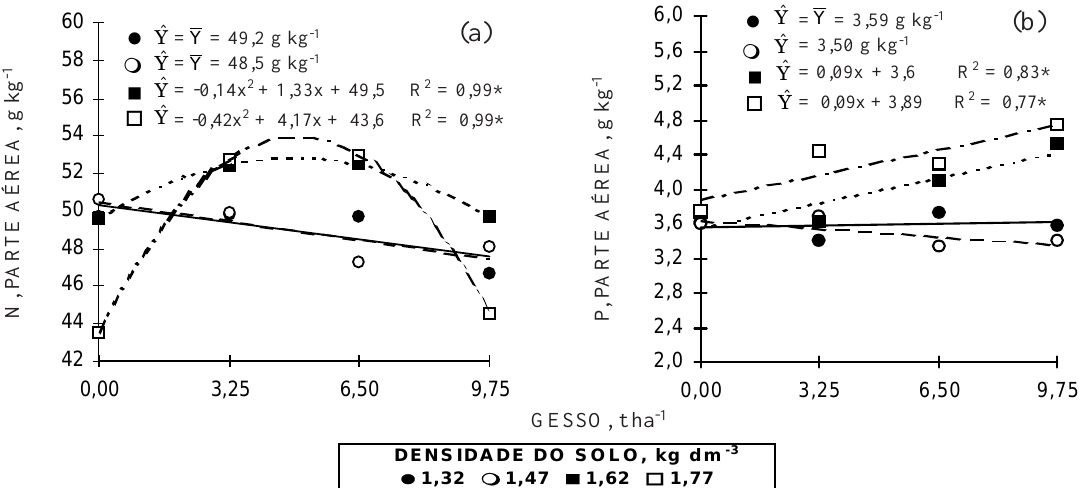
Figura 2. Concentrações de N (a) e de P (b) na parte aérea da soja, em função de doses de gesso + MSC, dentro de cada densidade do solo do anel central